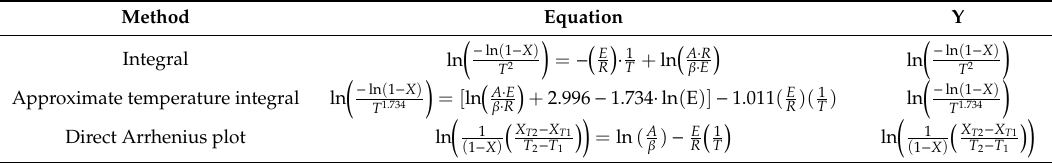
Table 3. Representative equations of the selected kinetic methods. Adapted from [9,12].